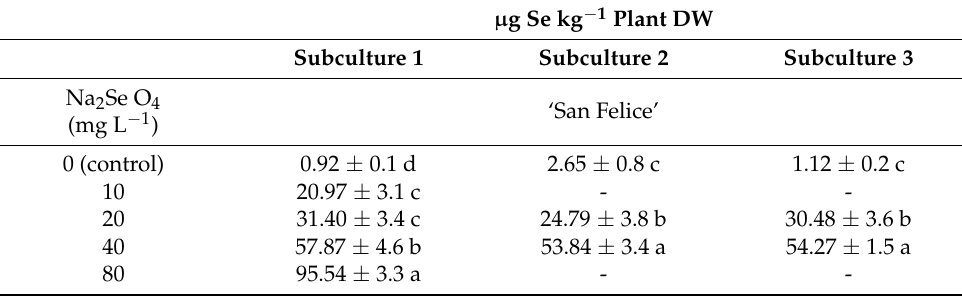
Table 5. Total Se content in explants ( µ g kg − 1 plant DW) at the end of the